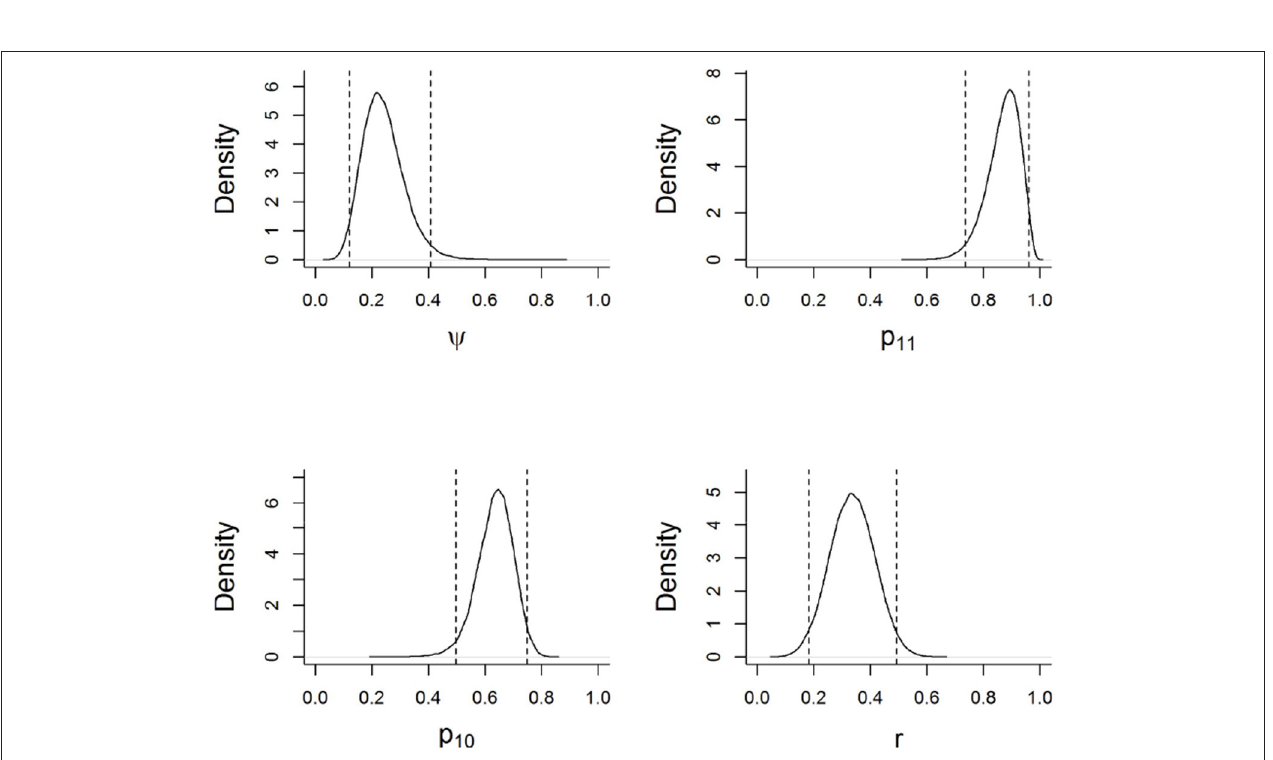
FIGURE 2 | Marginal posterior distributions for model parameters based on the best supported model. Parameters are described in Figure 1. Dotted lines indicate 95% credible intervals (i.e., the range of possible values that the parameter may take, given the data, the model, and the prior information).